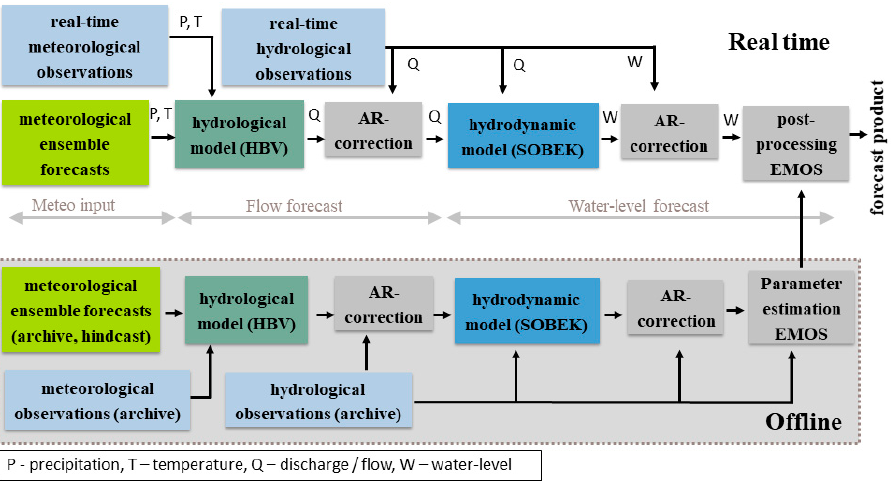
Figure 2. Schematic overview of the workflow for the 10-day forecast of the River Rhine.